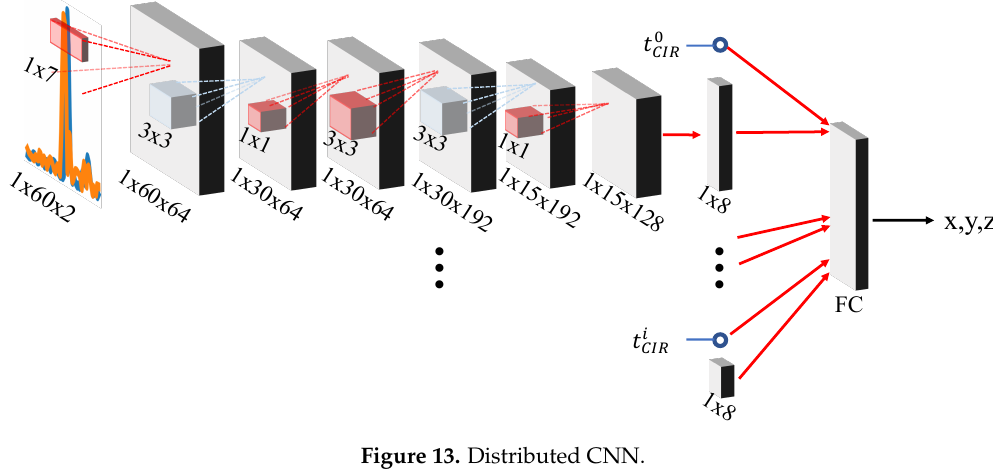
Figure 13. Distributed